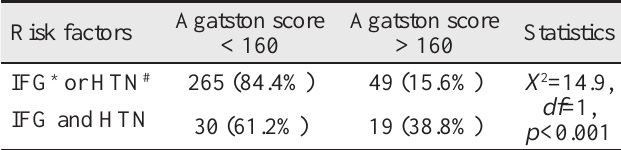
Table 2 : Agatston score category in patients with either both diabetes and hypertension or only one of those condition (N =